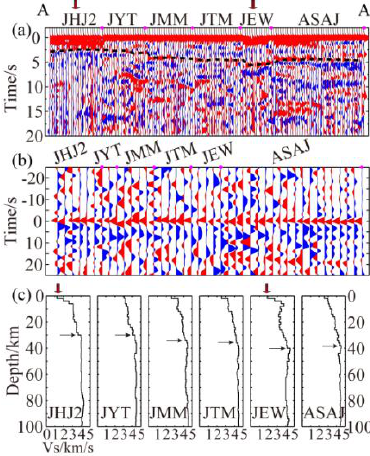
Figure 3: The P receiver functions (a) and S receiver functions (b) along profile A- A’ (location shown in Figure 1). The upper characters on each subgraph represent the station codes. The black dashed line in (a) denotes the P-to-s conversion wave from Moho. The S wave velocity structures within 100km depth (c) from joint analysis of P- and S receiver functions. The black arrows in each subgraph represent the Moho depth of each station. The red arrows on the top of (a) and (c) has marked out the stations with